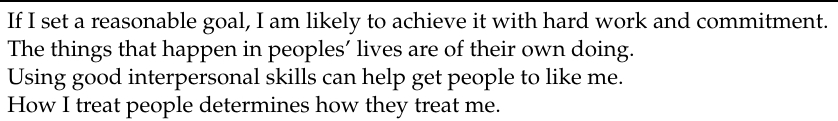
Table A1. Measurement of locus of